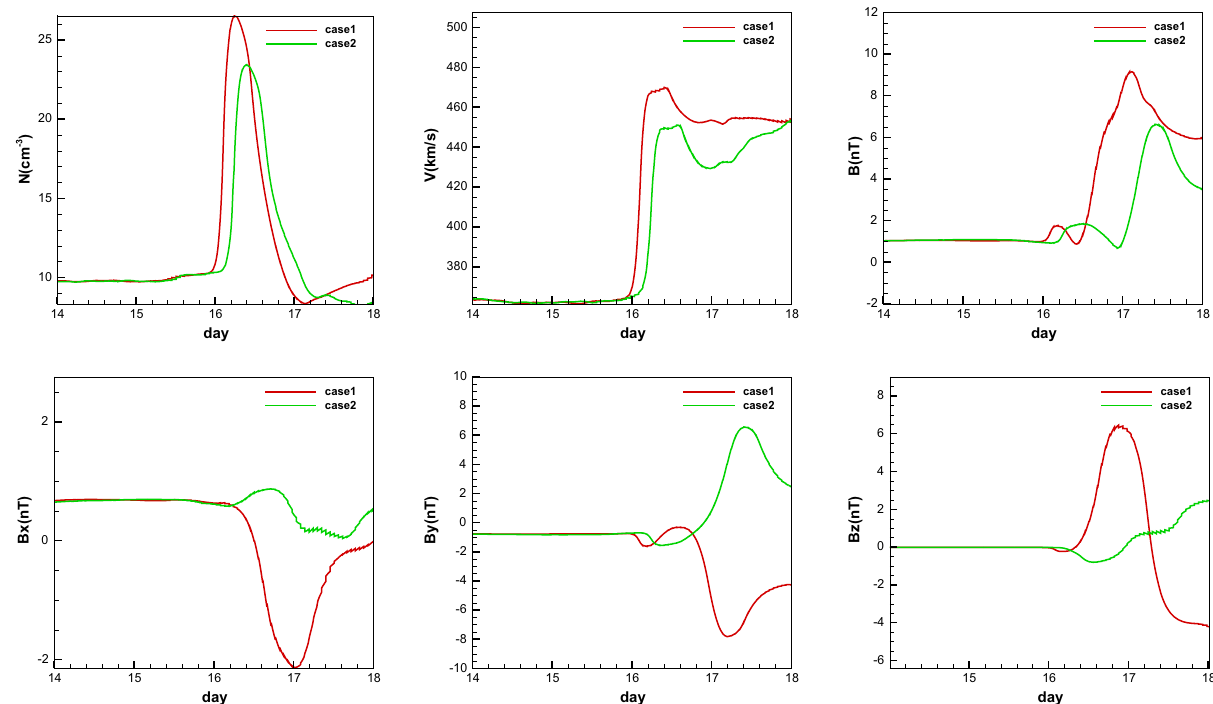
Fig. 16. Evolution of solar wind parameters at the Earth with different magnetic fi eld direction in the CME. The fi rst row present the number density (left), fl ow velocity (middle), magnetic fi eld (right), and the second row are the three components of magnetic fi eld ( B x , B y , B z ) in GSE coordinates.